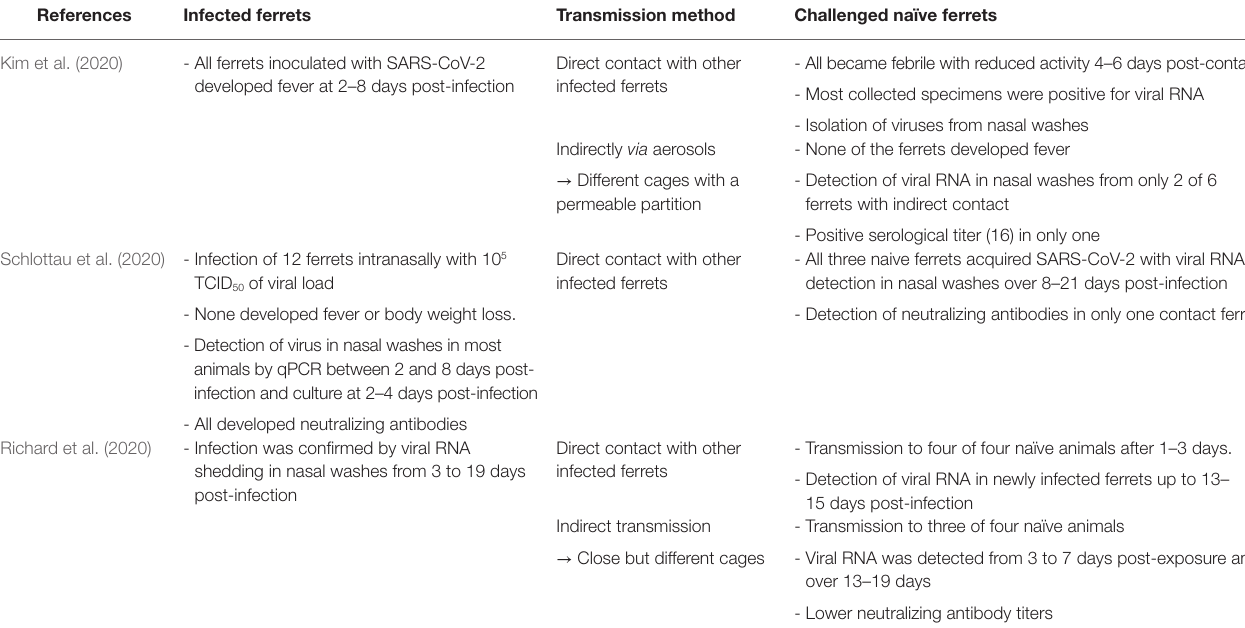
TABLE 2 | Evaluation of SARS-CoV-2 transmission between